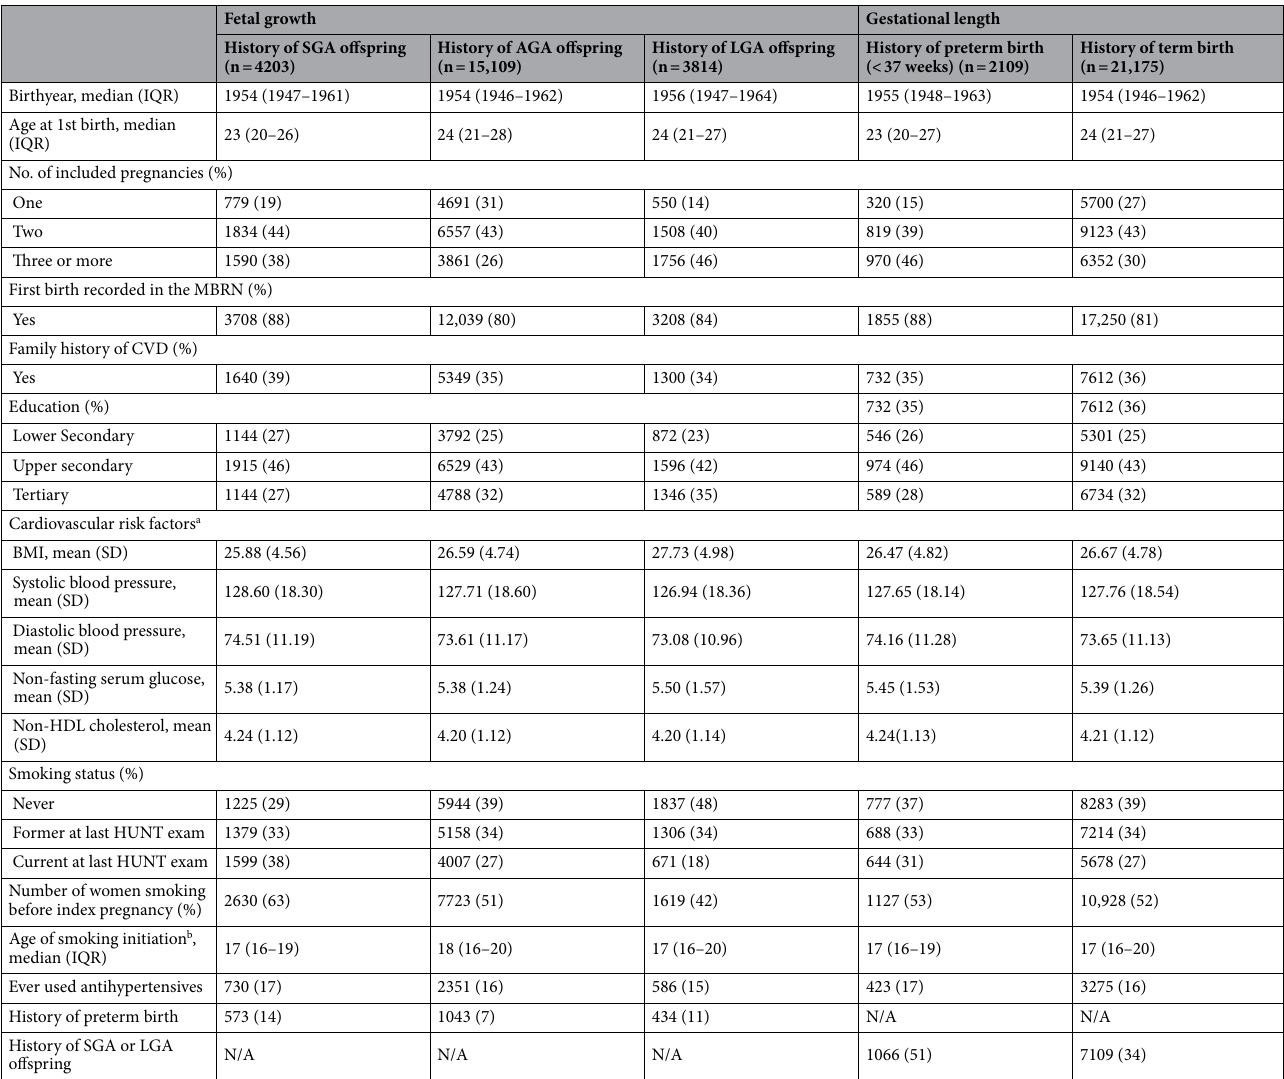
Table 1. Maternal descriptive characteristics according to history of pregnancy complication. a Due